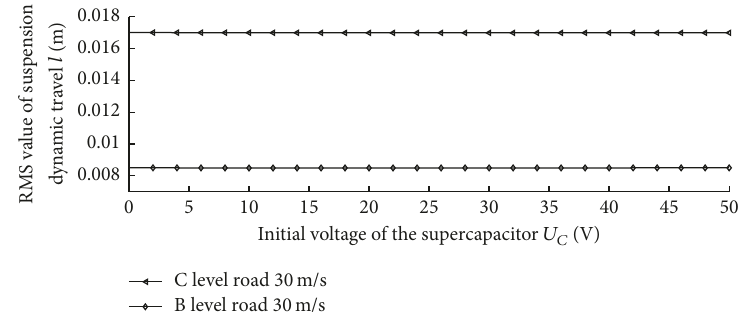
Figure 4: The relationship between suspension dynamic travel and supercapacitor initial terminal voltage.